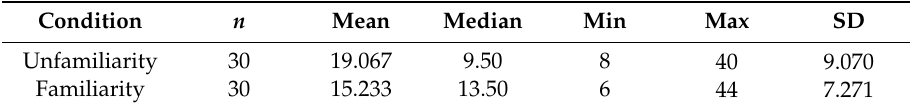
Table 16. Descriptive statistics for the number of product web page surfed.